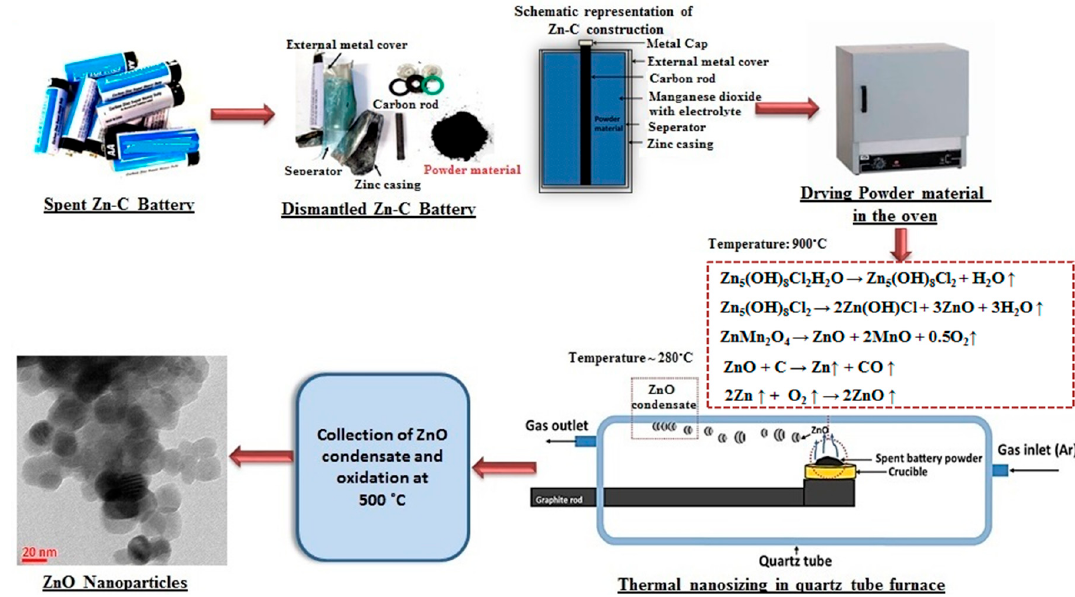
Figure 1. An overall flow diagram to synthesize ZnO from spent Zn-C battery which includes schematic representation of typical Zn-C battery construction, dismantled battery fraction, experimental set up and synthesized ZnO nanoparticles.